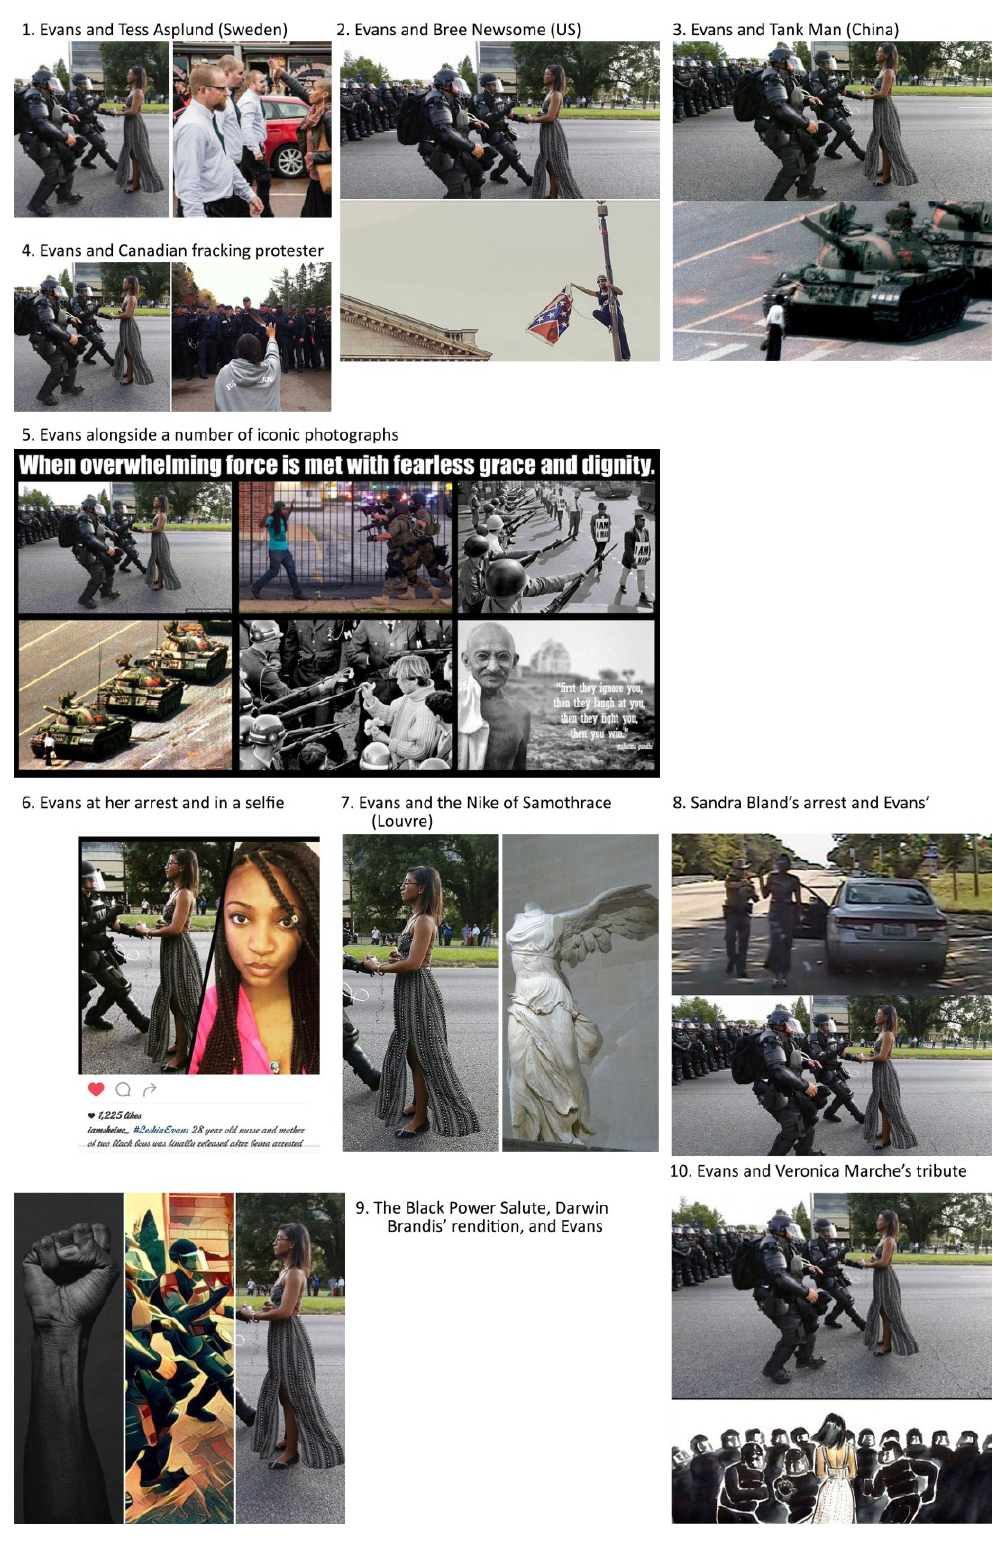
Figure 5. Pictorial comparisons. Source: Twitter.